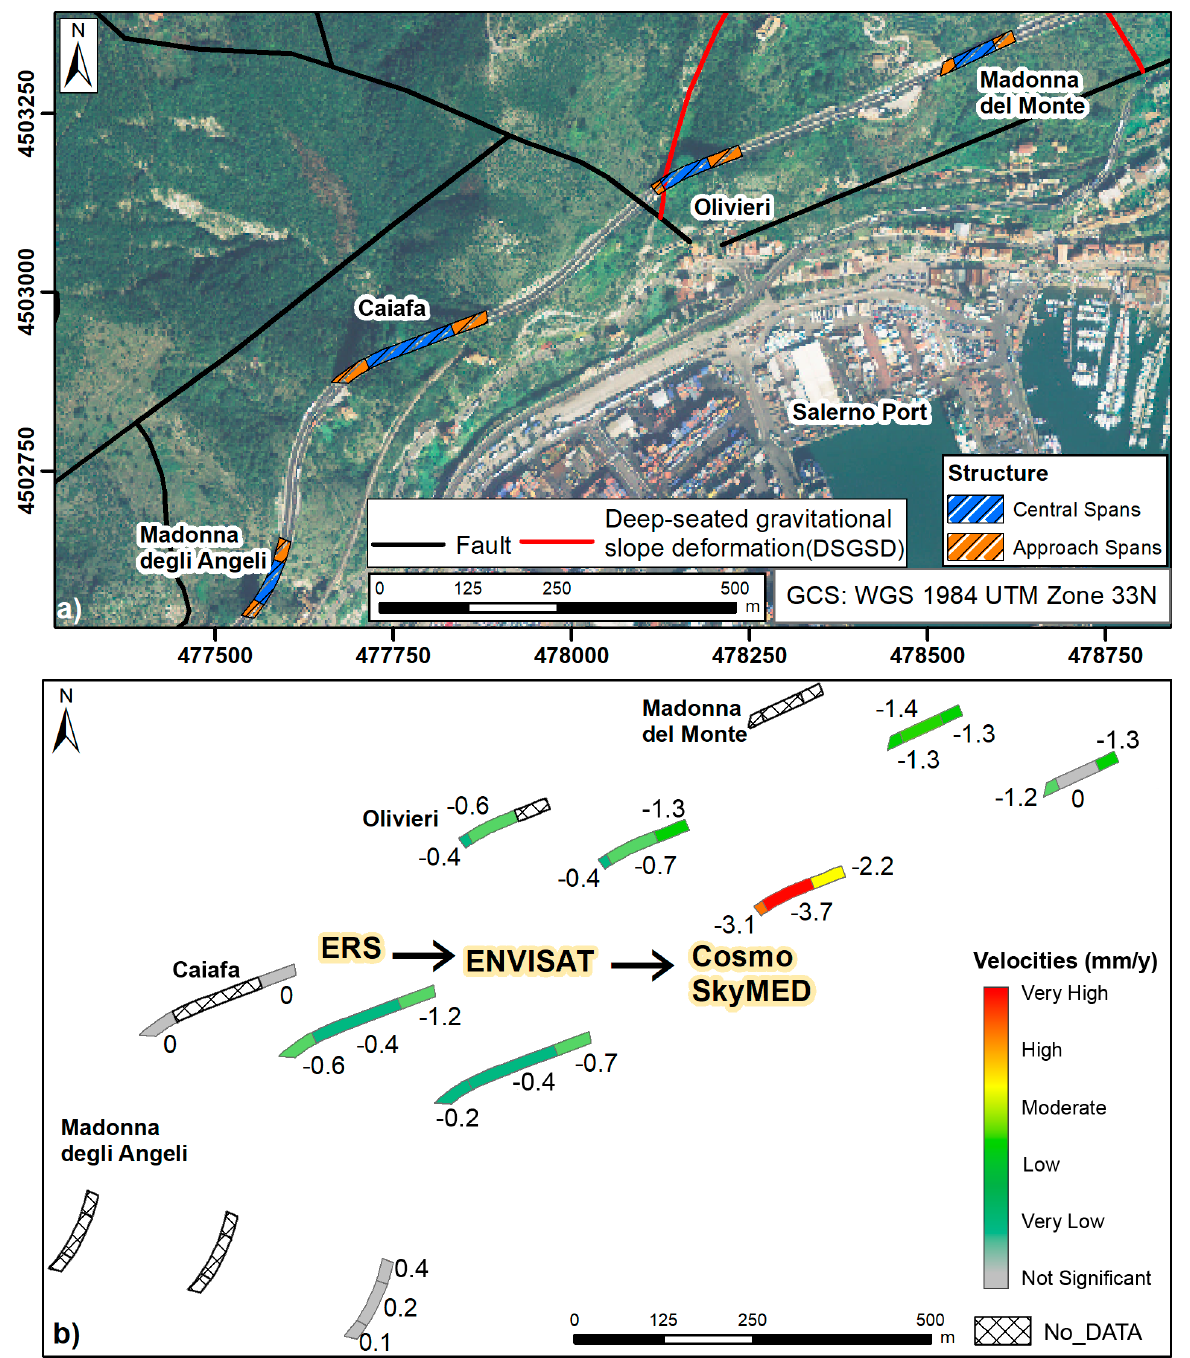
Figure 8. ( a ) Location of the analyzed viaducts and their man structural parts and ( b ) classification of the viaduct structural parts according to the velocities for the three SAR datasets.